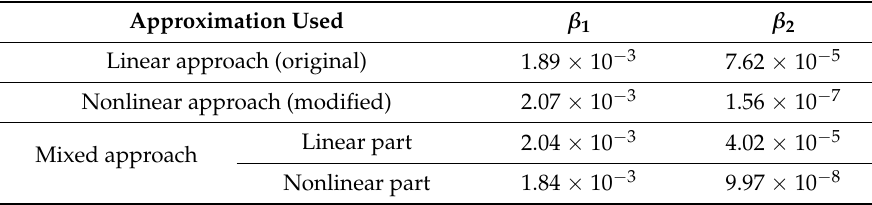
Table 4. Parameters β 1 and β 2 for each